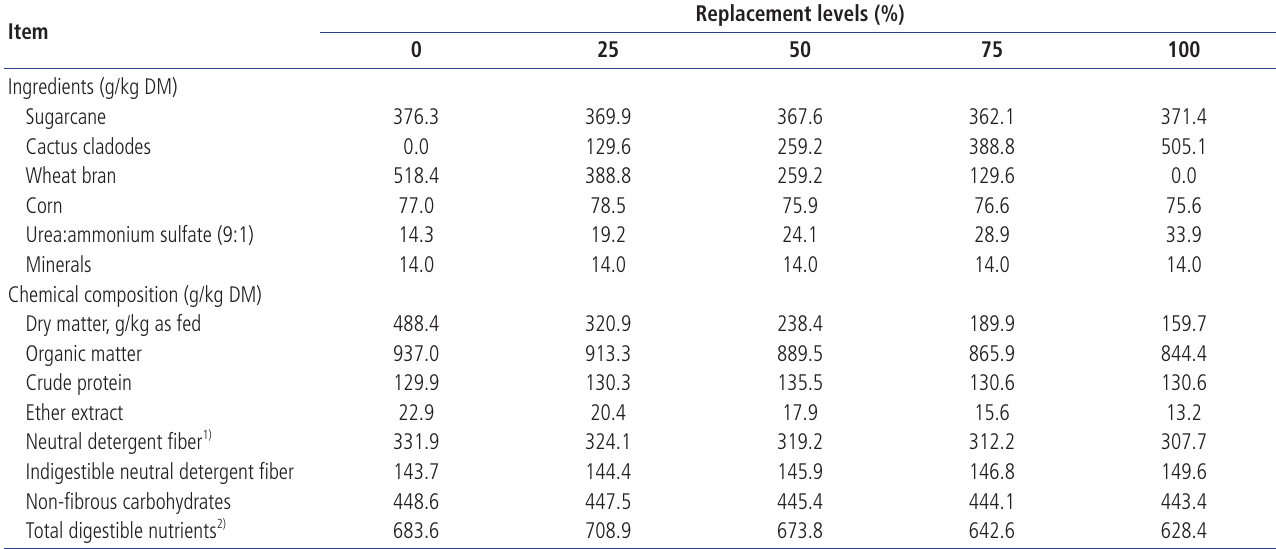
Table 2. Ingredients proportions and chemical composition of dietary treatments for steers fed cactus cladodes plus urea